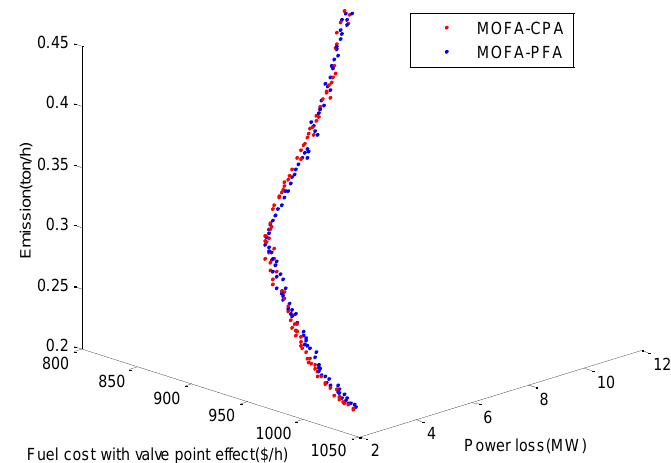
Figure 5. PFs obtained by MOFA-CPA and MOFA-PFA for Case 5.